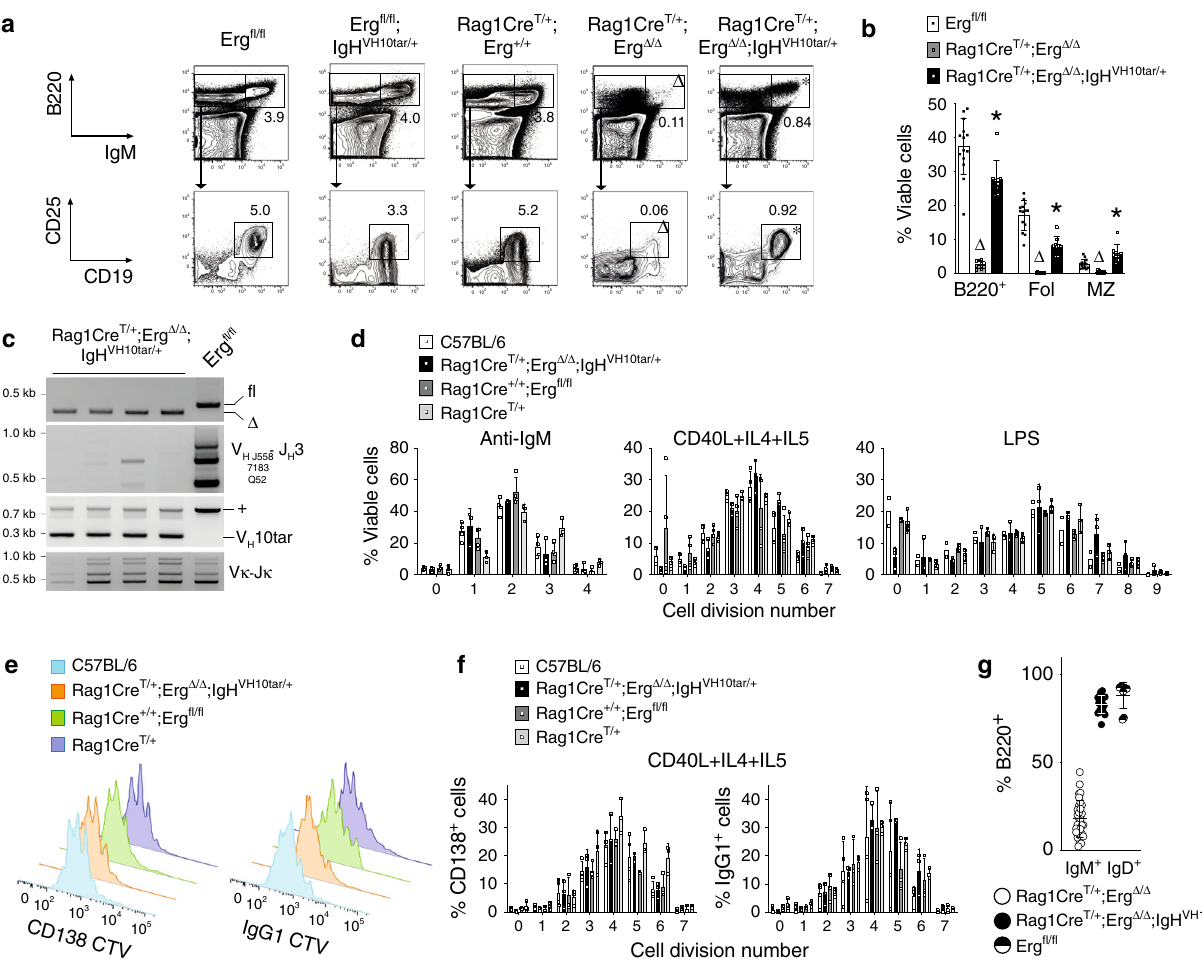
Fig. 3 Rearranged Igh allele permits B-lymphoid development in the absence of Erg. a Representative fl ow cytometry plots of BM B lymphoid populations ( n = 9 Erg fl / fl , n = 8 Erg fl / fl ; IgH VH10tar/ + , n = 7 Rag1Cre T/ + , n = 8 Rag1Cre T/ + ; Erg Δ / Δ , n = 8 Rag1Cre T/ + ; Erg Δ / Δ ; IgH VH10tar/ + biologically independent samples) with mean percentage of viable cells indicated; B220/IgM pro fi le from whole BM, CD25/CD19 pro fi le from B220 + IgM − BM cells. Δ P adj = 2.1e − 9 (B220 + IgM + ) and 3.5e − 4 (B220 + IgM − CD25 + CD19 + ) comparing Rag1Cre T/ + ; Erg Δ / Δ to Erg fl / fl ; * P adj = 3.1e − 3 (B220 + IgM + ) and 3.3e − 2 (B220 + IgM − CD25